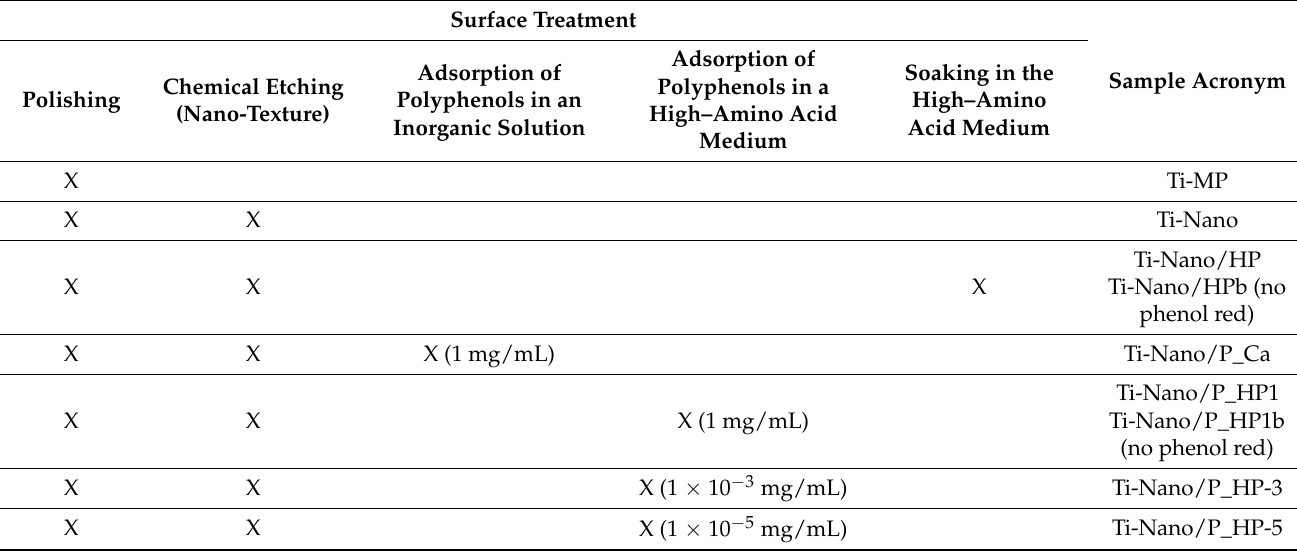
Table 1. Codification and description of the